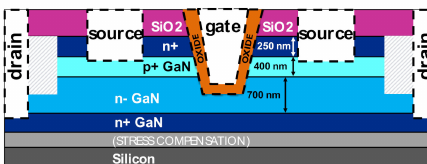
Figure 1. Structural schematic of the studied semi vertical trench